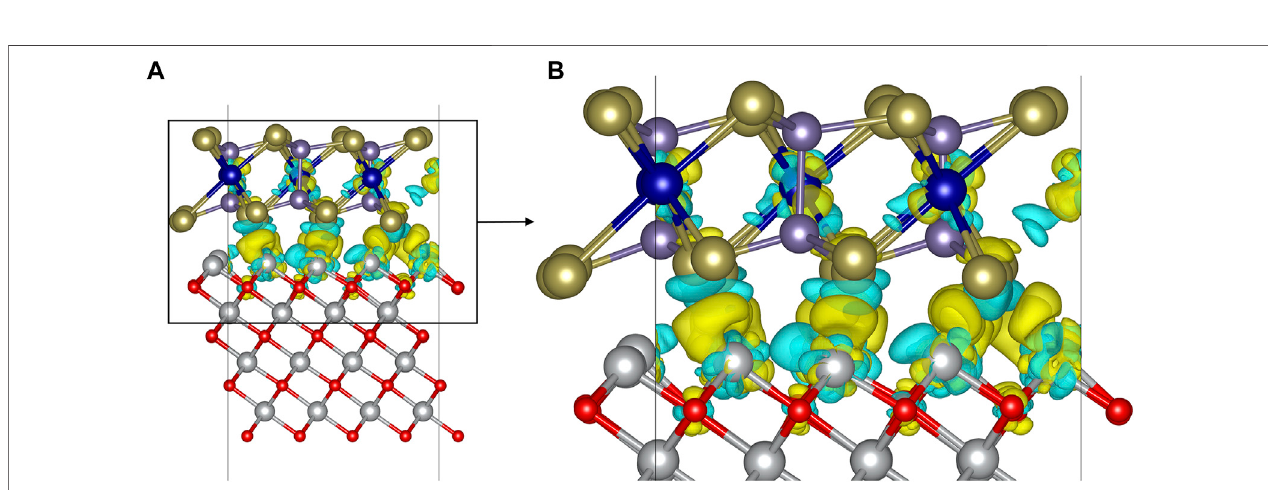
FIGURE 2 | Differential charge density (A) and its local enlarged view (B) of the CrGeTe 3 /NiO interface in the FM2 state. The isosurface is set to 0.021 e/Å 3 .